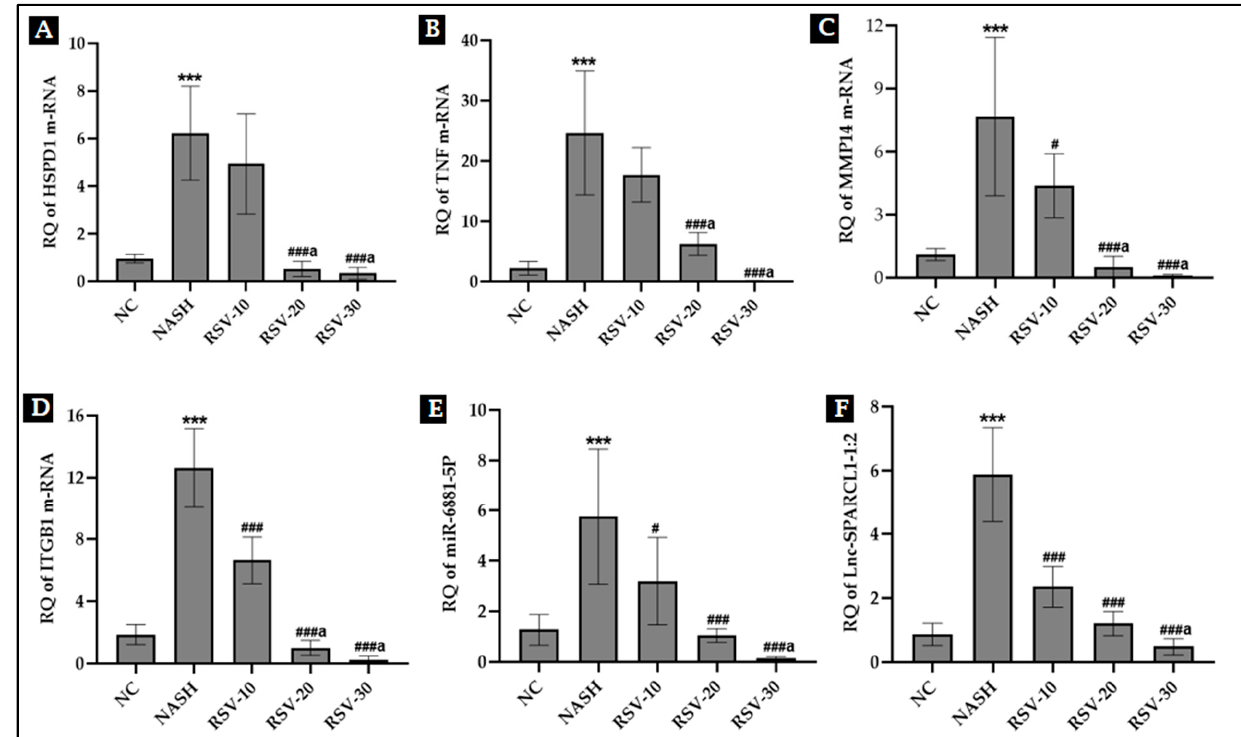
Figure 4. Effect of rosavin treatment on the expression level of hepatic m-RNAs: HSPD1 , TNF , MMP14 , and ITGB1 ( A – D ); ( E ): hepatic miRNA-6881-5P and ( F ): hepatic LncRNA SPARCL1 -1:2. Values are mean ± SD; number of animals = 8 rats/each group. *** p < 0.001 vs. NC group; ### p < 0.001, and # p < 0.05 vs. NASH group. a p < 0.05 compared to RSV-10. One-way ANOVA followed by Tukey’s multiple comparison test RQ, relative quantification.